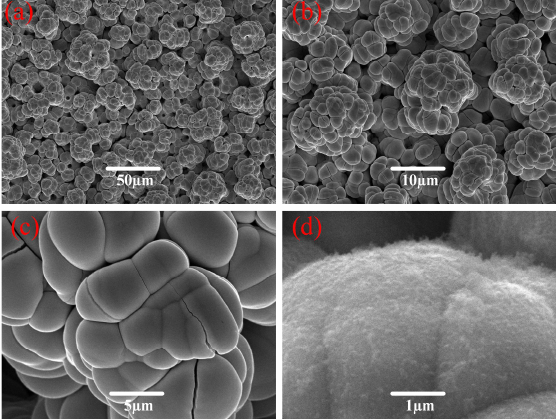
Figure 2. Scanning electron microscopy (SEM) images of Ti6Al4V alloy surfaces obtained in the concentration of 400 g/L at the voltage of 25 V, the relative velocity of 7 m/min, and the processing time of 5 min with different magnifications—( a ) 500×, ( b ) 1000×, ( c ) 5000×, and ( d ) 20,000×.